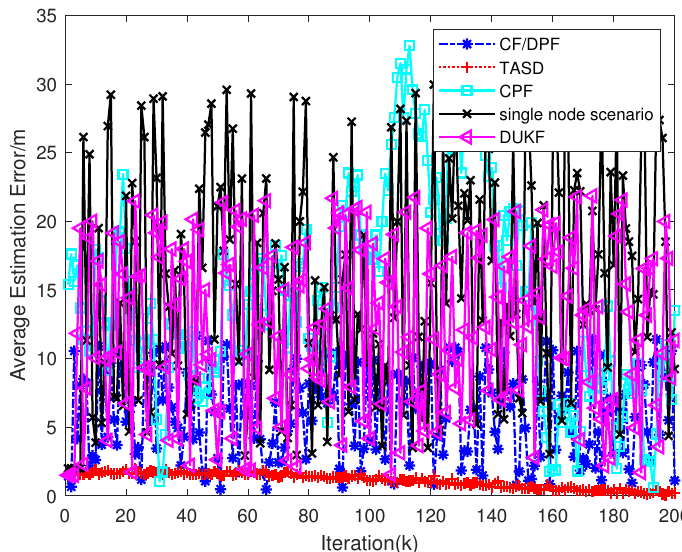
Figure 8. Average estimation errors in a large-scale sparse and dynamic UWSN.